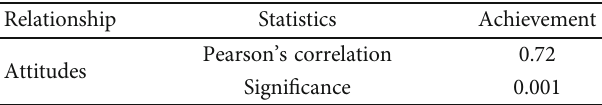
Table 6: Pearson ’ s correlation coe ffi cients for students ’ attitudes and